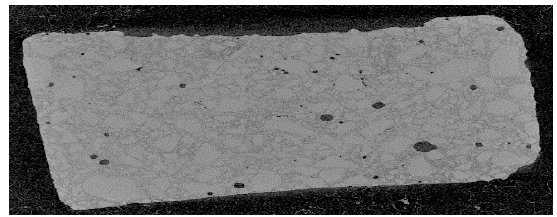
Figure 3. Tomography (internal diameter cut view, diameter: 10 mm) of the sample consolidated by freeze isostatic pressure (FIP) showing a non-uniform distribution of pores and inhomogeneous repartition of solvent (presence of agglomerates).